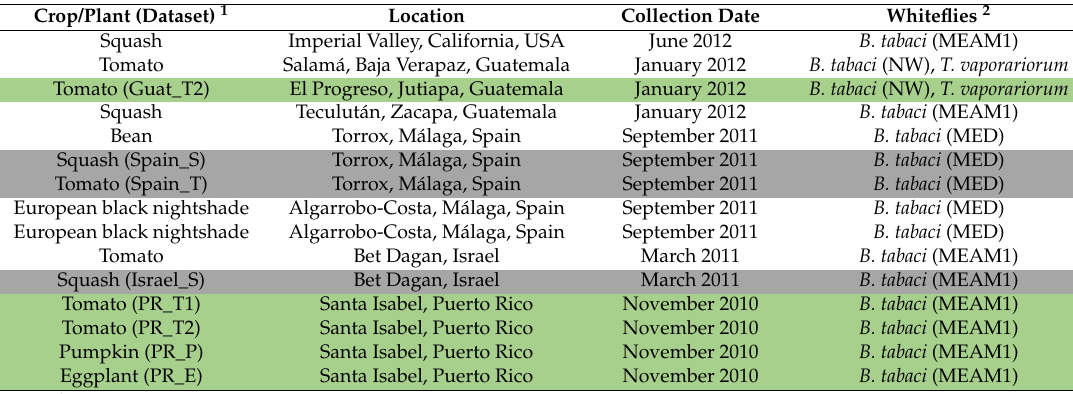
Table 1. Whitefly samples used for vector-enabled metagenomic (VEM) survey of begomovirus-associated satellite DNAs